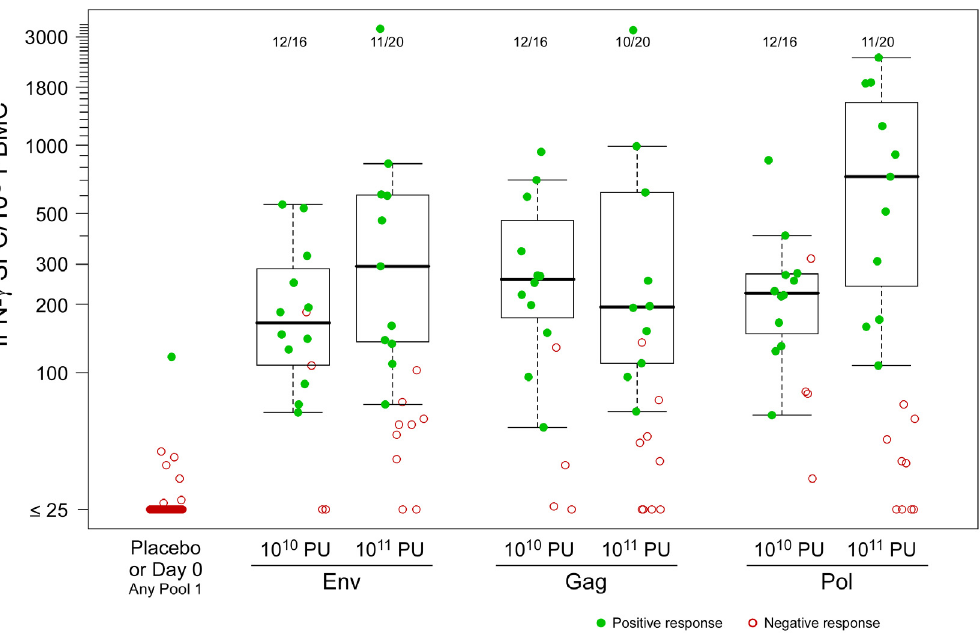
Figure 6. Magnitudes of T-cell responses to pool 1 global PTE peptides, measured by IFN- c ELISpot assay. Day 0 (left column) is a combined analysis including responses from PBMC from placebo recipients; day 28 (remaining columns) is sorted by HIV-1 gene product. The box plots are based only on the positive responses. The box indicates the median and interquartile range (IQR); whiskers extend to the furthest point within 1.5 times the IQR from the upper or lower quartile. The number of vaccinees with a positive response out of the total number of vaccinees tested is indicated above the bars.